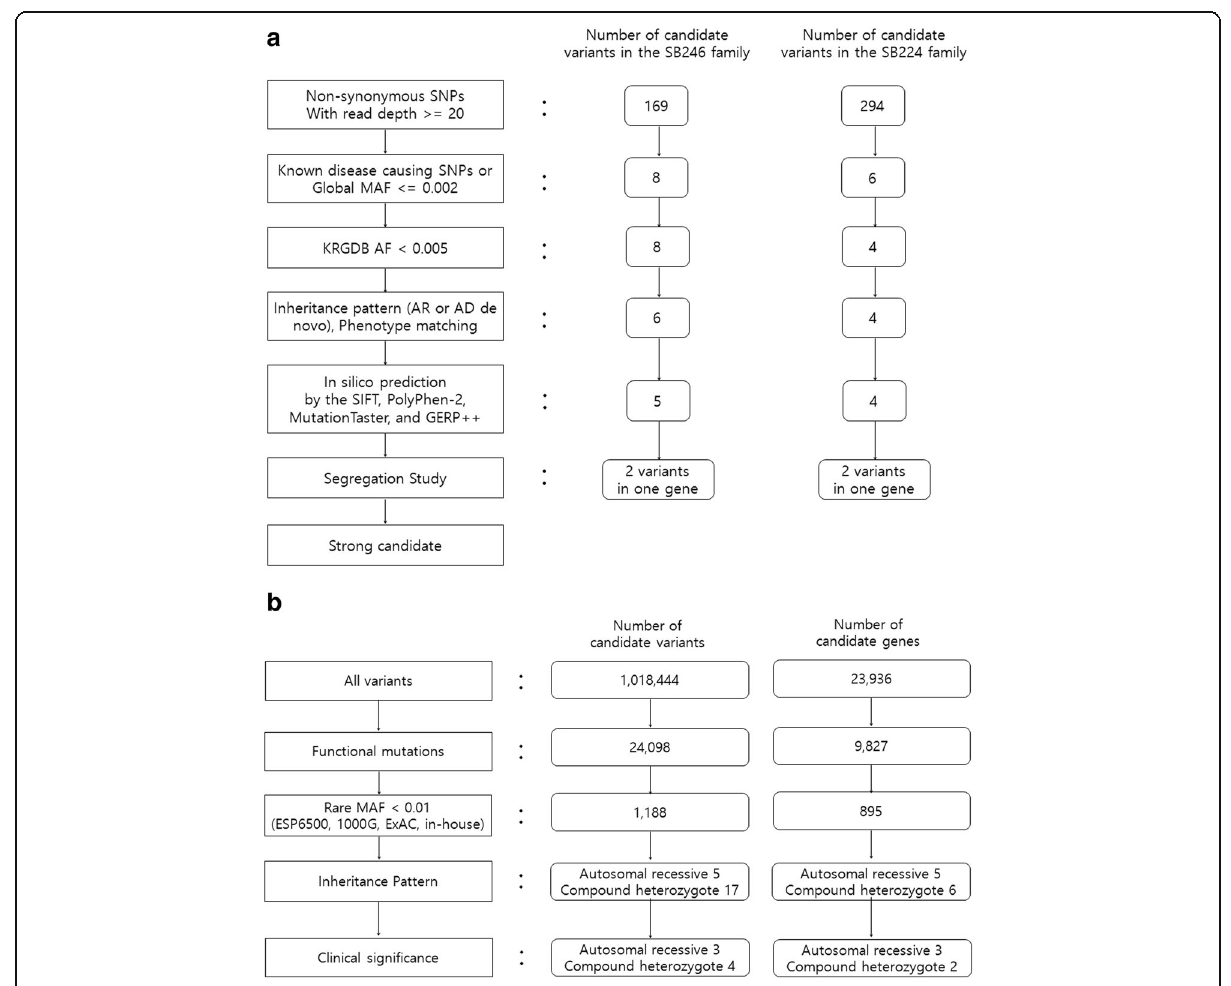
Fig. 2 Schematic flowchart of filtering of causative variants in this study. a Targeted exome sequencing. b Whole exome sequencing. AR, autosomal recessive; AD, autosomal